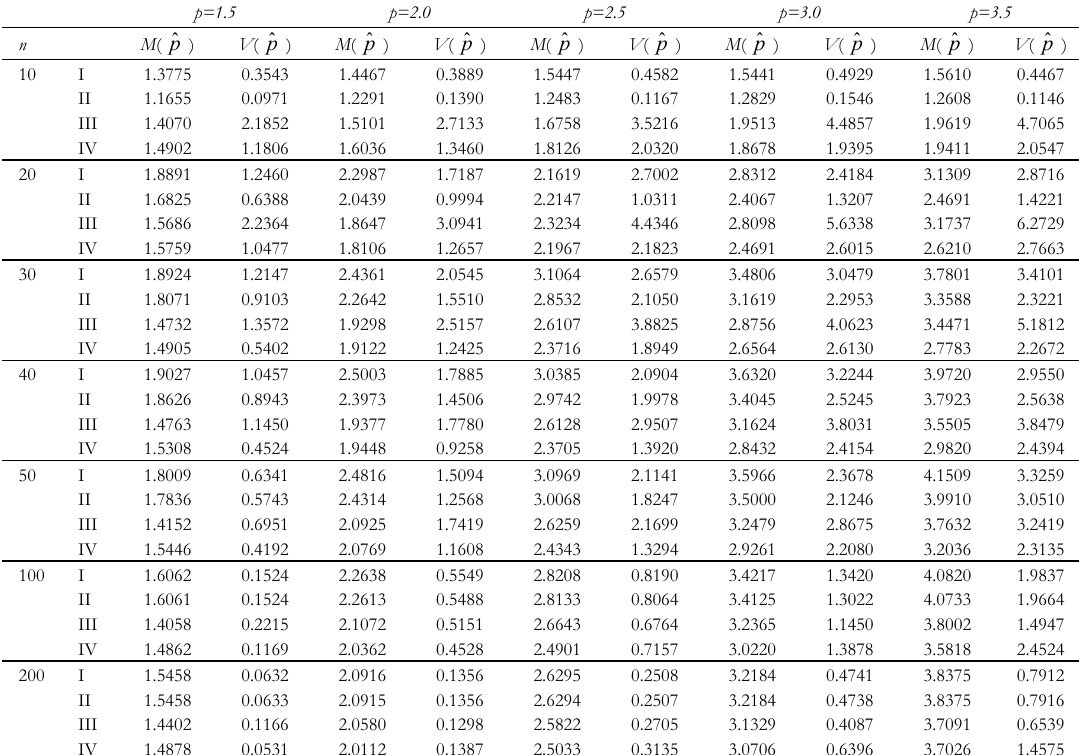
Arithmetic means (M) and variances (V) of the structure parameter p estimates for the four used methods (I=whole log-likelihood, II=profile log-likelihood, III=conditional profile log-likelihood, IV=method based on the index ˆ VI ).